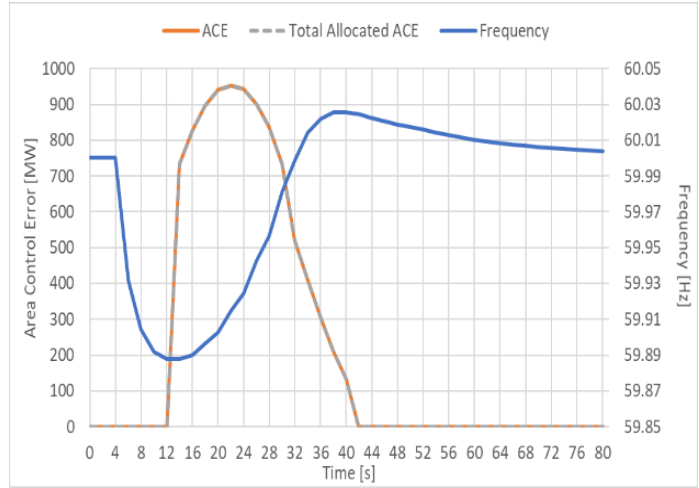
Figure 13. Example of area control error allocation using the proposed simulation model ( upper ) and comparison of between the total allocated area control error and pre-allocated area control error ( lower ).